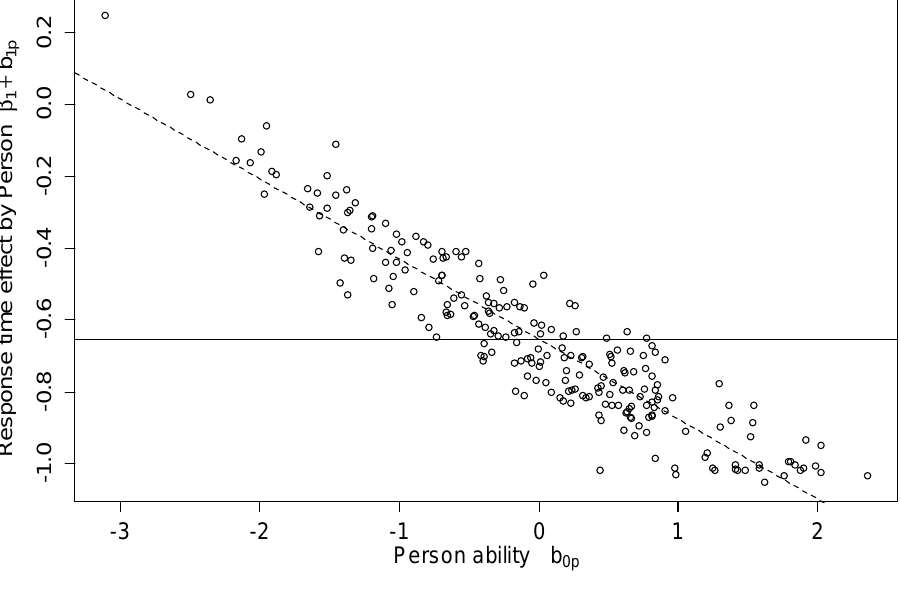
Figure 1. Item response time effect by person. The solid line indicates the fixed response time effect, the dots show how the response time effect is adjusted by person. For less able individuals the item response time effect gets more positive, whereas for able persons it gets more